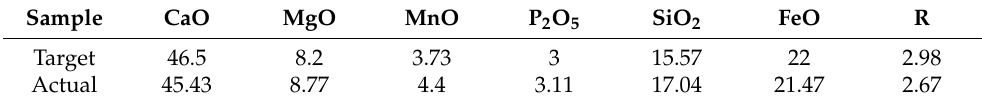
Table 1. Target compositions and actual compositions of decarburization slag (mass%).